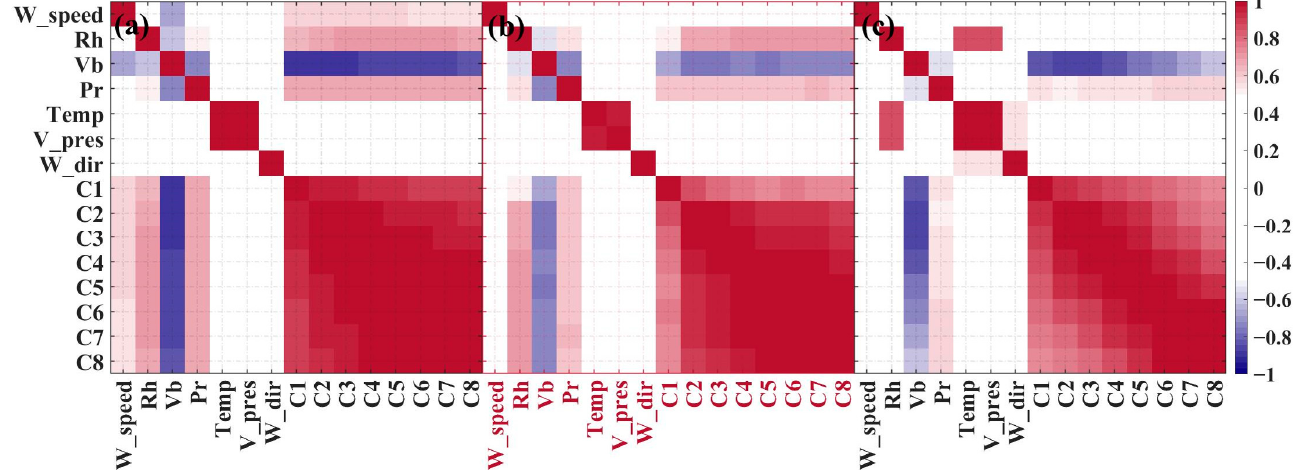
Figure 2. Correlation between observation elements under ( a ) other situations vs. blowing snow, ( b ) other situations vs. fog, ( c ) blowing snow vs. fog.